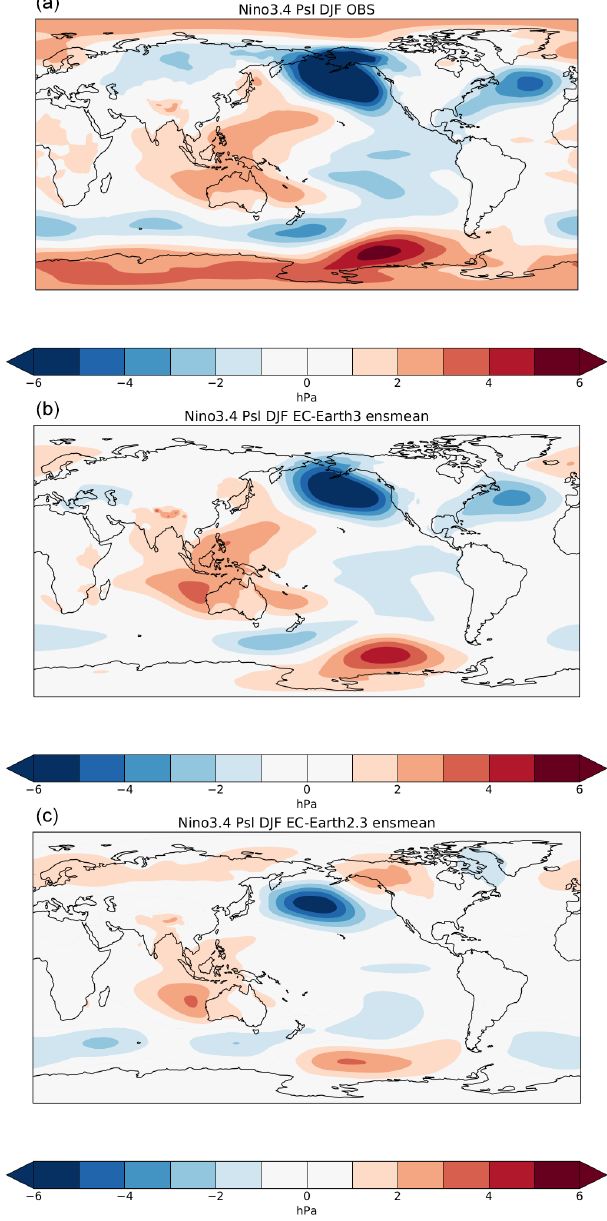
Figure 19. Regression of Niño3.4 SST index onto sea level pressure during winter (DJF) for the ERA-20C reanalysis (a) , 20-member EC-Earth3 ensemble mean (b) , and 4-member EC-Earth2.3 ensem- ble mean (c) . Analyses are based on 3-month means for December–